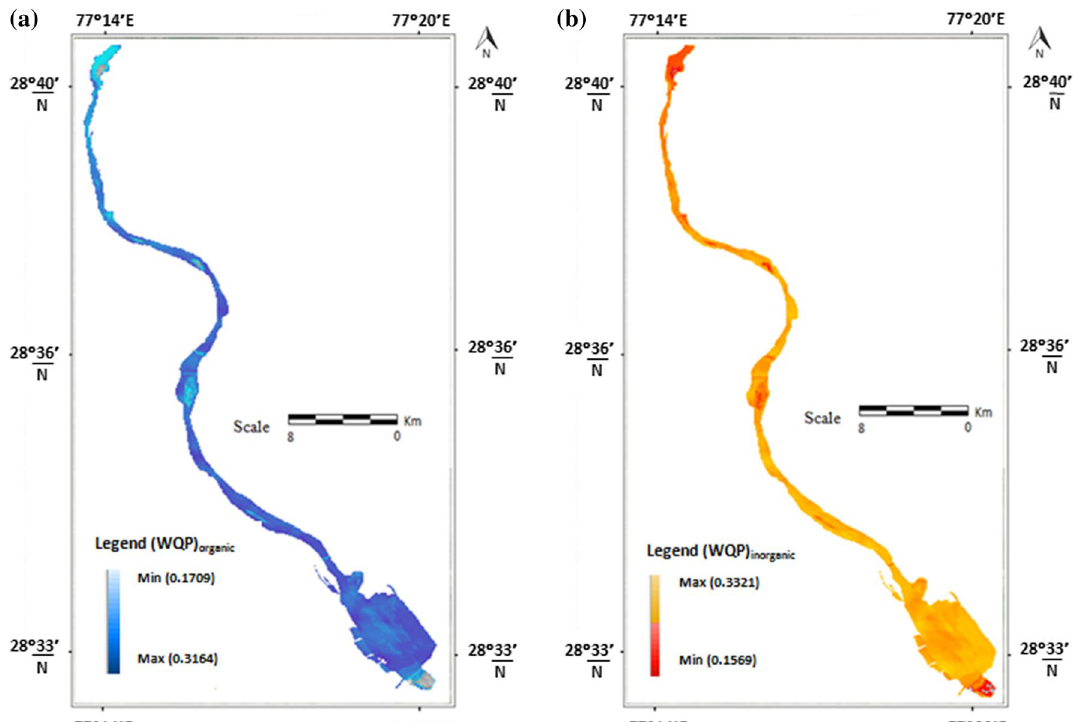
organic and b (WQP)